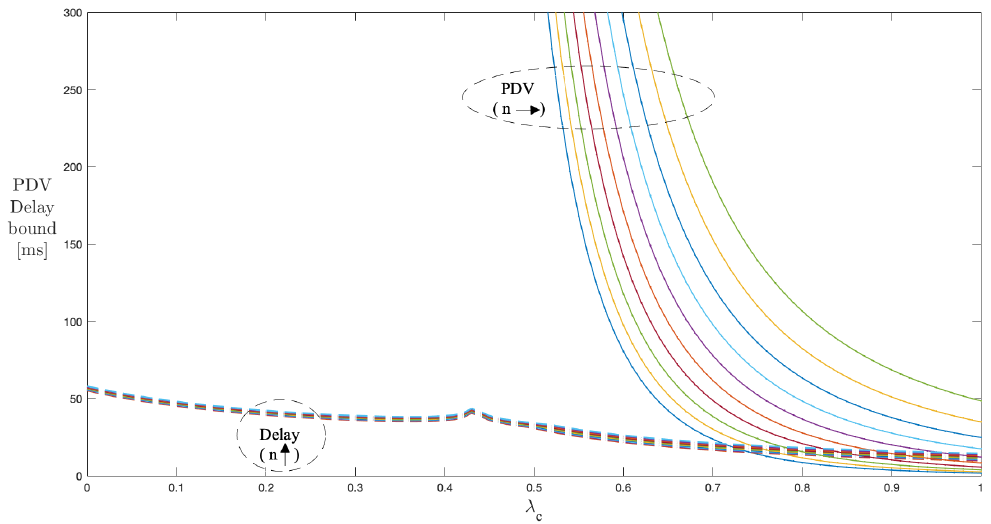
Figure 8. Impact of n and λ c on the PDV bound in a multi-stage network (constant µ c